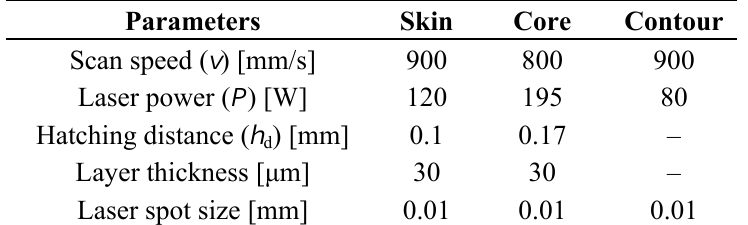
Table 1. Direct metal laser sintering (DMLS) process parameters employed.